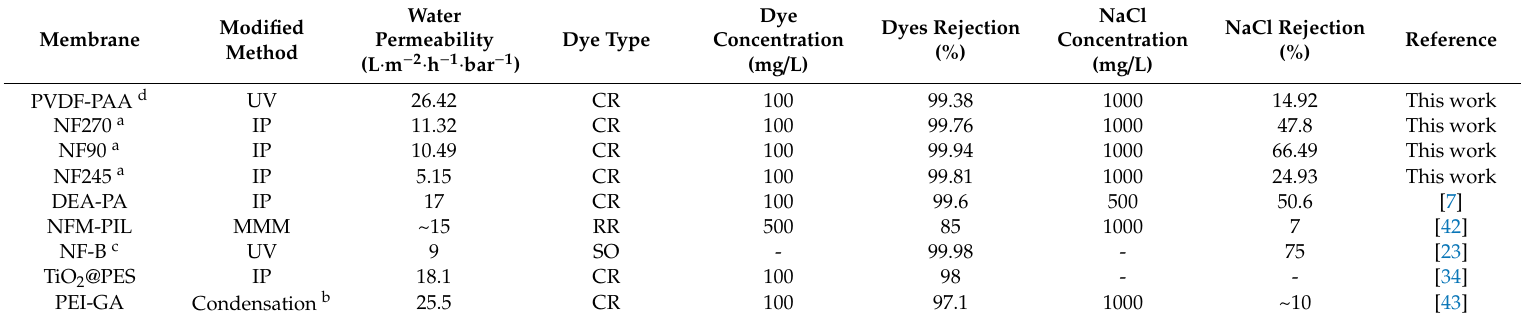
Table 2. Comparison of the dye separation nanofiltration membrane in the literature and commercial membrane.